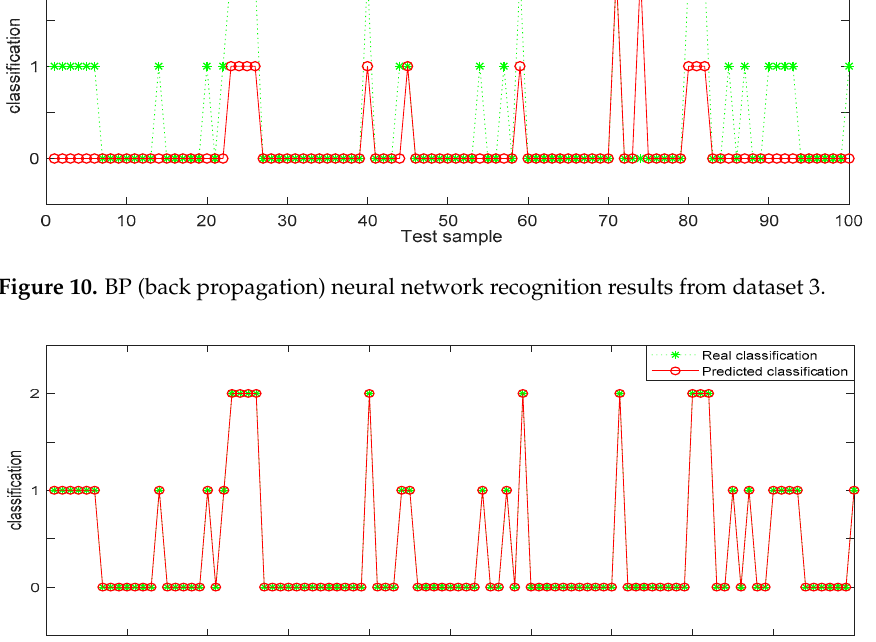
Figure 11. Random forest identification results from dataset 3.